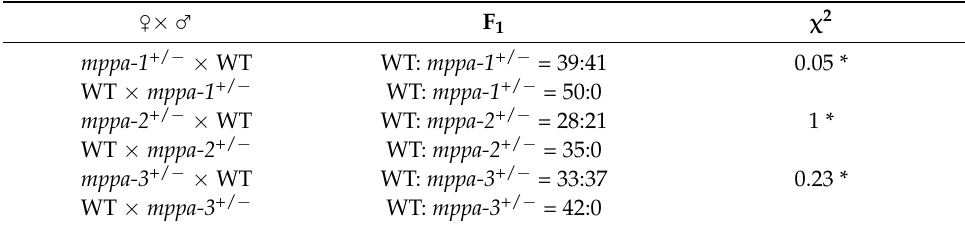
Table 2. Reciprocal crosses between mppa +/ − and